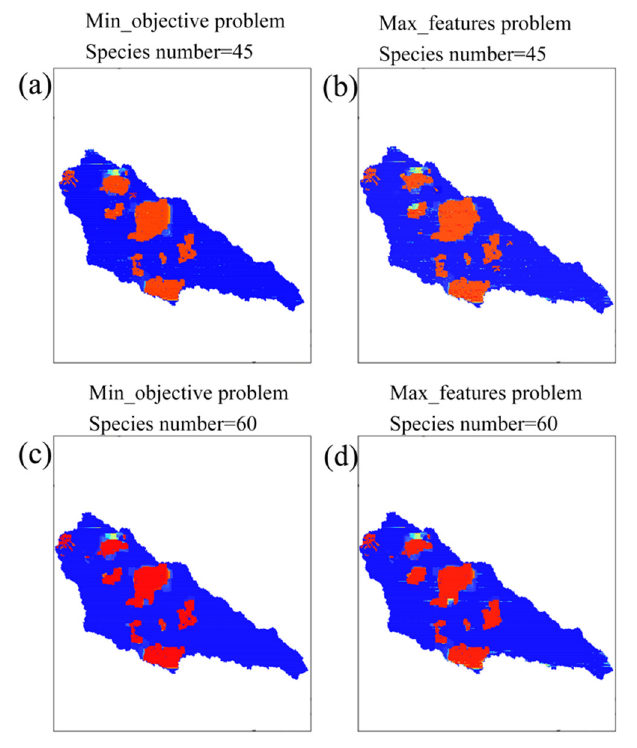
Figure 5. Vegetation restoration priority area by prioritizr for different, species number and problem solutions. Across all panels, filled in red grid cells represent selected planning units for all the time period (1000 times), filled blue in grid cells represent not selected planning units (0 times). (a ） Min_objective problem,species number=45;(b) Max_features problem,species number=45;(c) Min_objective problem,species number=60;(d) Max_features problem,species number=45.